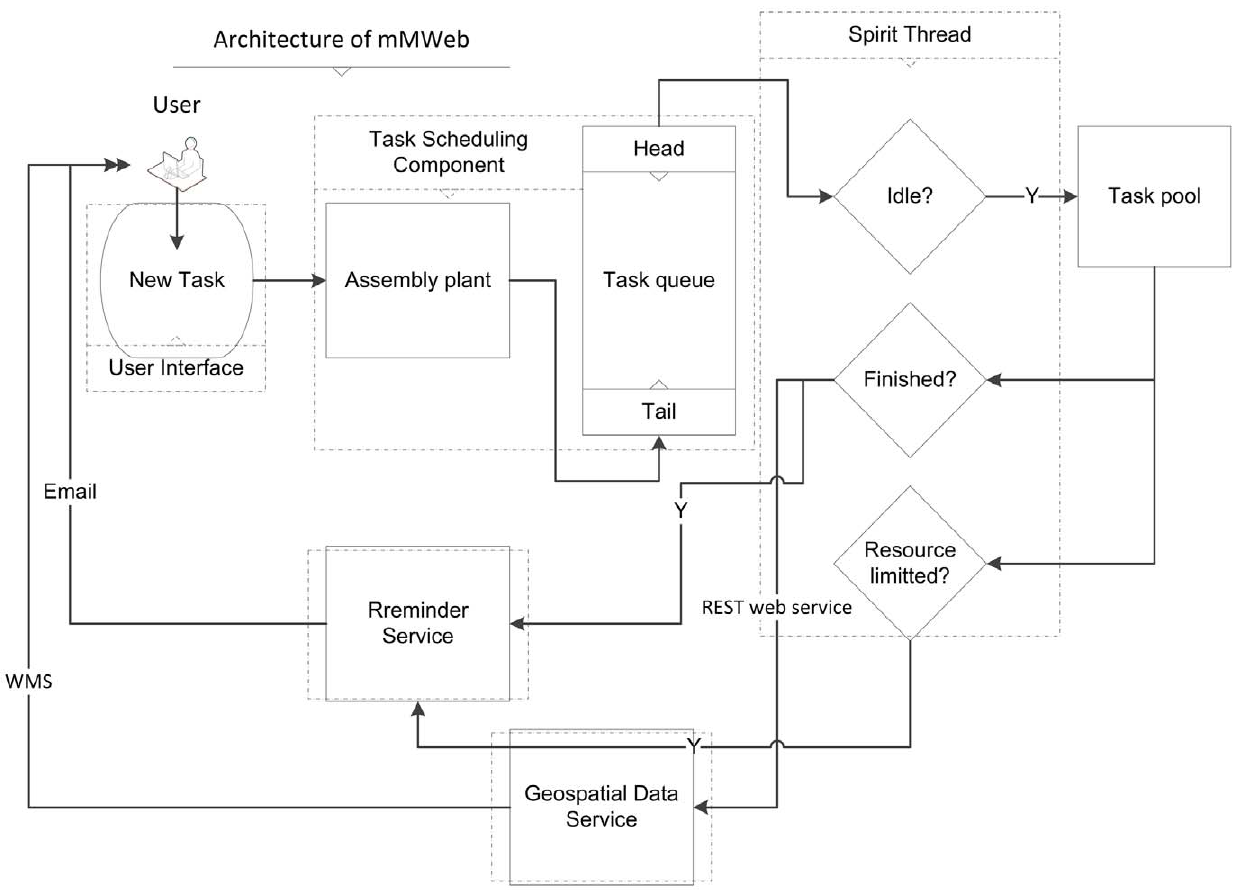
Figure 1. The flowchart of mMWeb. mMWeb consists of four independent modules: User interface, Task-scheduling component, Reminder service, and Geospatial data service.